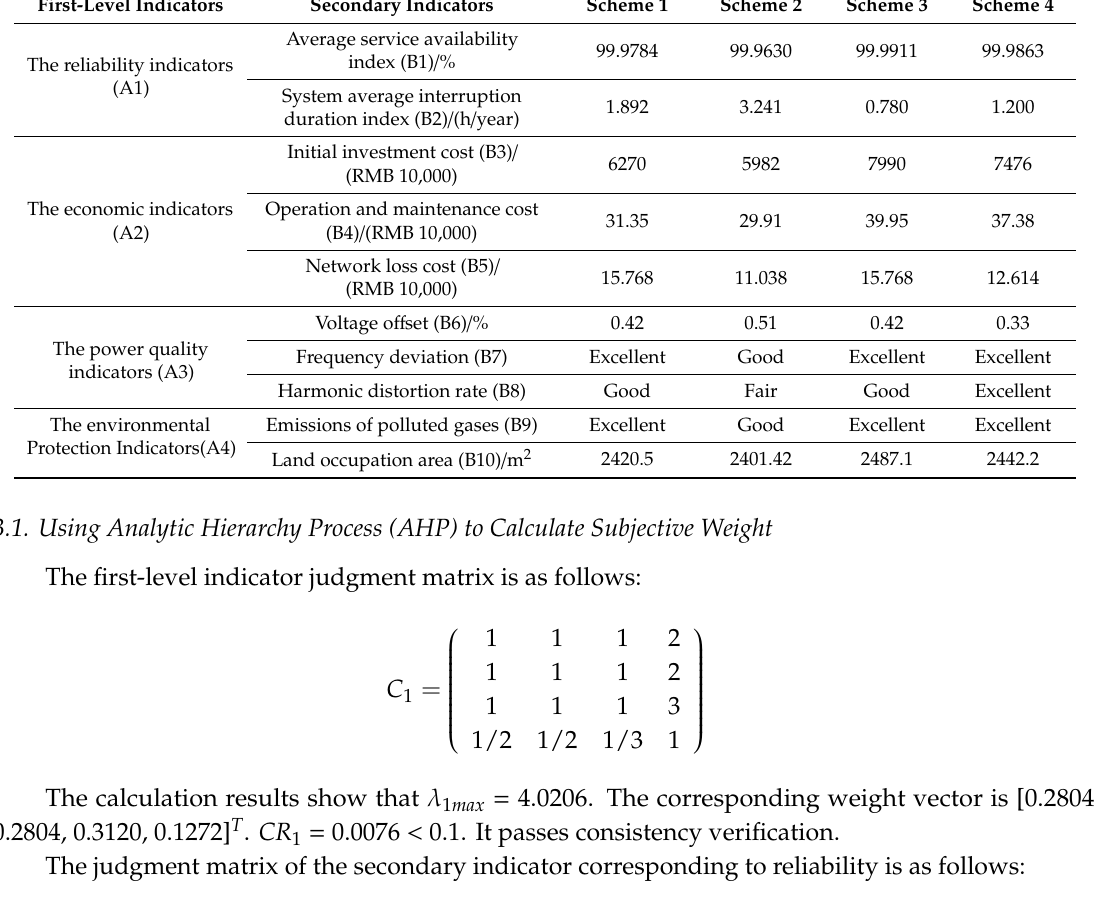
The calculation results show that λ 2 max = 2.0000. The corresponding weight vector is [0.6667, 0.3333] T . CR 2 = 0 < 0.1. It passes consistency